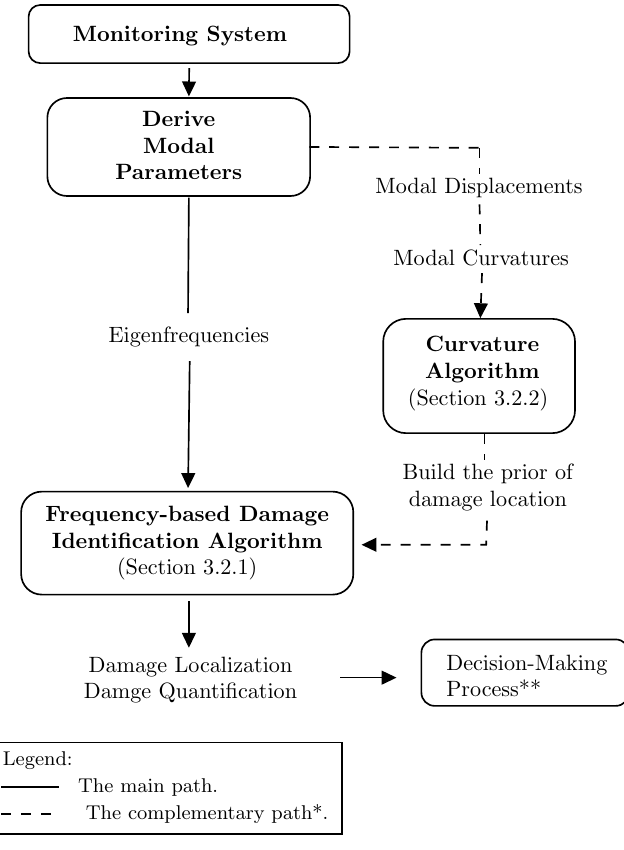
Figure 4. The flow chart of the proposed